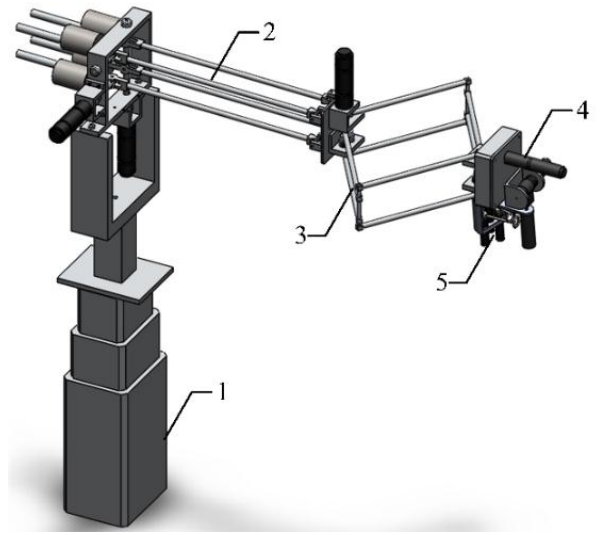
Figure 1. General assembly drawing ( 1 ) Base; ( 2 ) Double parallel linkage; ( 3 ) Rhombus linkage; ( 4 ) Rotating mechanical structure; ( 5 ) Grasping interface.